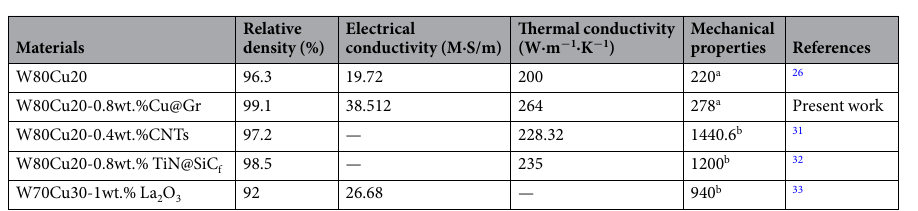
Figure 4. TEM images of Cu@Gr/WCu composites doped with 0.8 wt.% Cu@Gr after SPS sintering. ( a ) 0.8 wt.% Cu@Gr/WCu composites. ( b ) Electron diffraction pattern and calibration of 1 in Fig. 4(a). ( c ) Electron diffraction pattern and calibration of 2 in Fig. 4(a). ( d ) High magnification of marked 3 zone in Fig. 4(a). ( e ) High-magnification images of marked 4 zone in Fig. 4(d). ( f ) Electron diffraction pattern and calibration of marked 4 zone in Fig. 4(d).